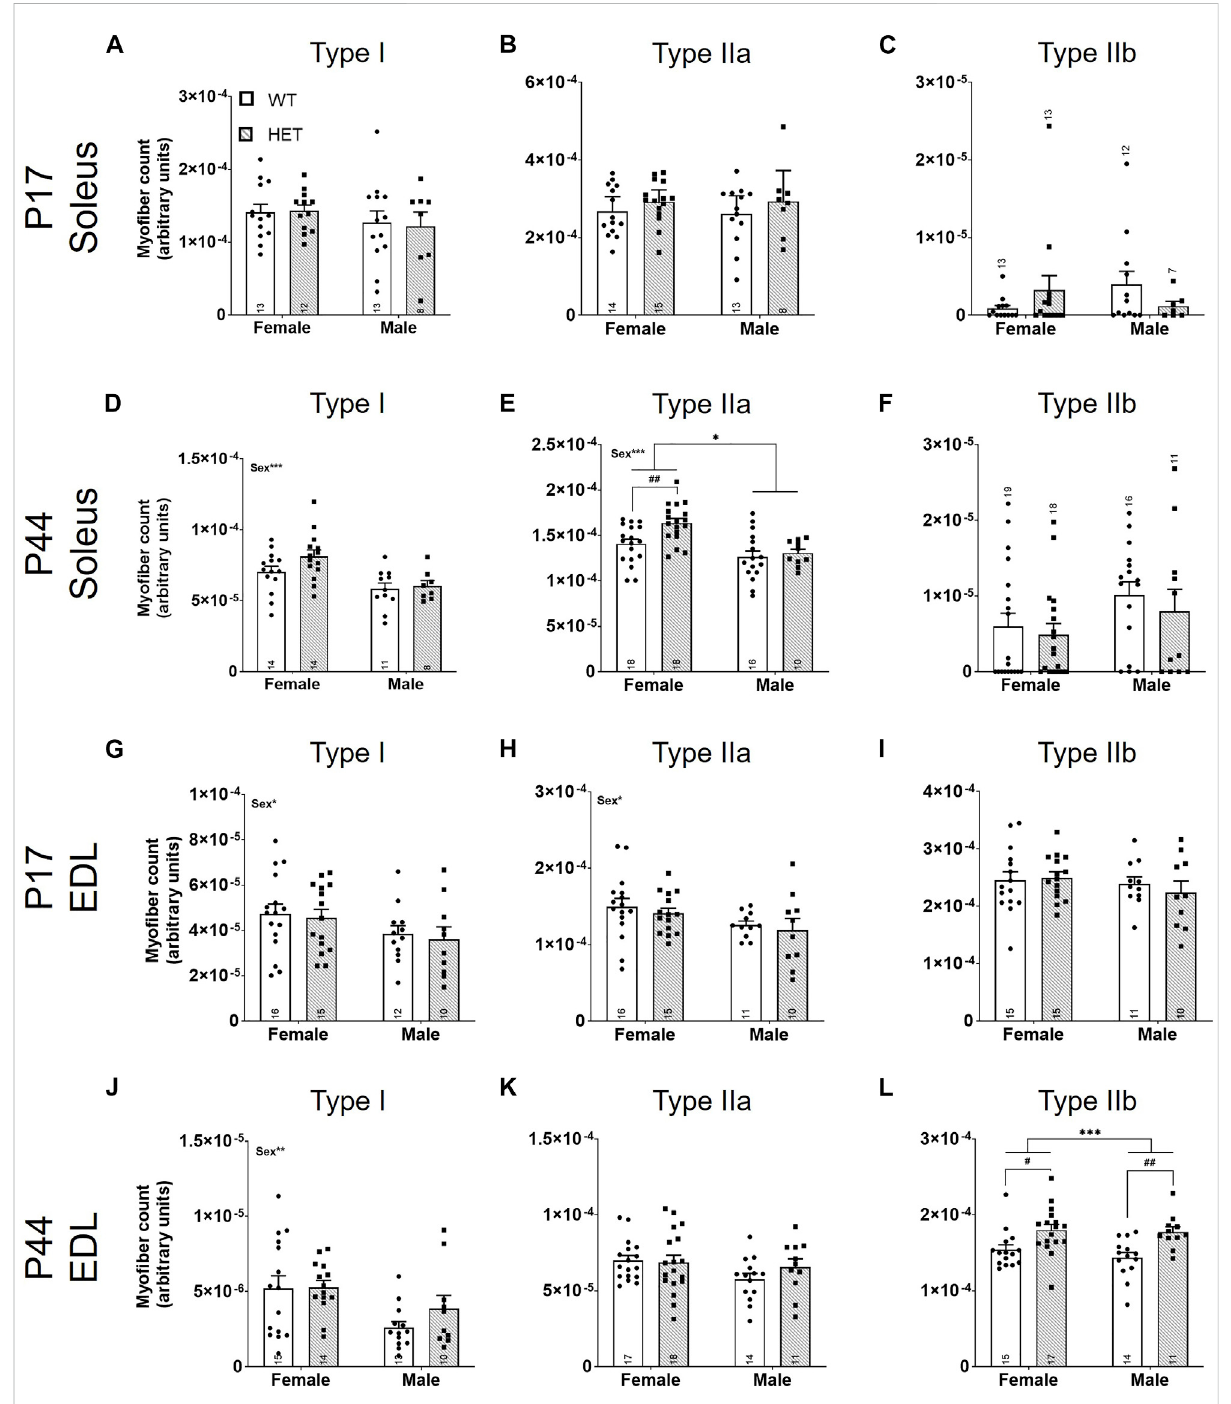
Fast-twitch myo fi ber counts are increased in HET muscles at P44. Myo fi ber types (I, IIa, and IIb) were scored using immuno fl uorescence. Individual myo fi bers per type were counted and normalized to the total area of the section (represented as myo fi ber count; y-axes). Graphs show each myo fi ber type in males and females from P17 SOL (A – C) , P44 SOL (D – F) , P17 EDL (G – I) , and P44 EDL (J – L) . WT : dots and open bars; HET : squares and grey hatched bars. * p < 0.05; ** p < 0.01; *** p < 0.001 (2-way ANOVA). # p < 0.05; ## p < 0.01 (post hoc test; effect of genotype only). Effects of sex by 2-way ANOVA testing are shown as text in the upper left of the panel. Error bars show ±SEM; number of biological replicates are shown within each